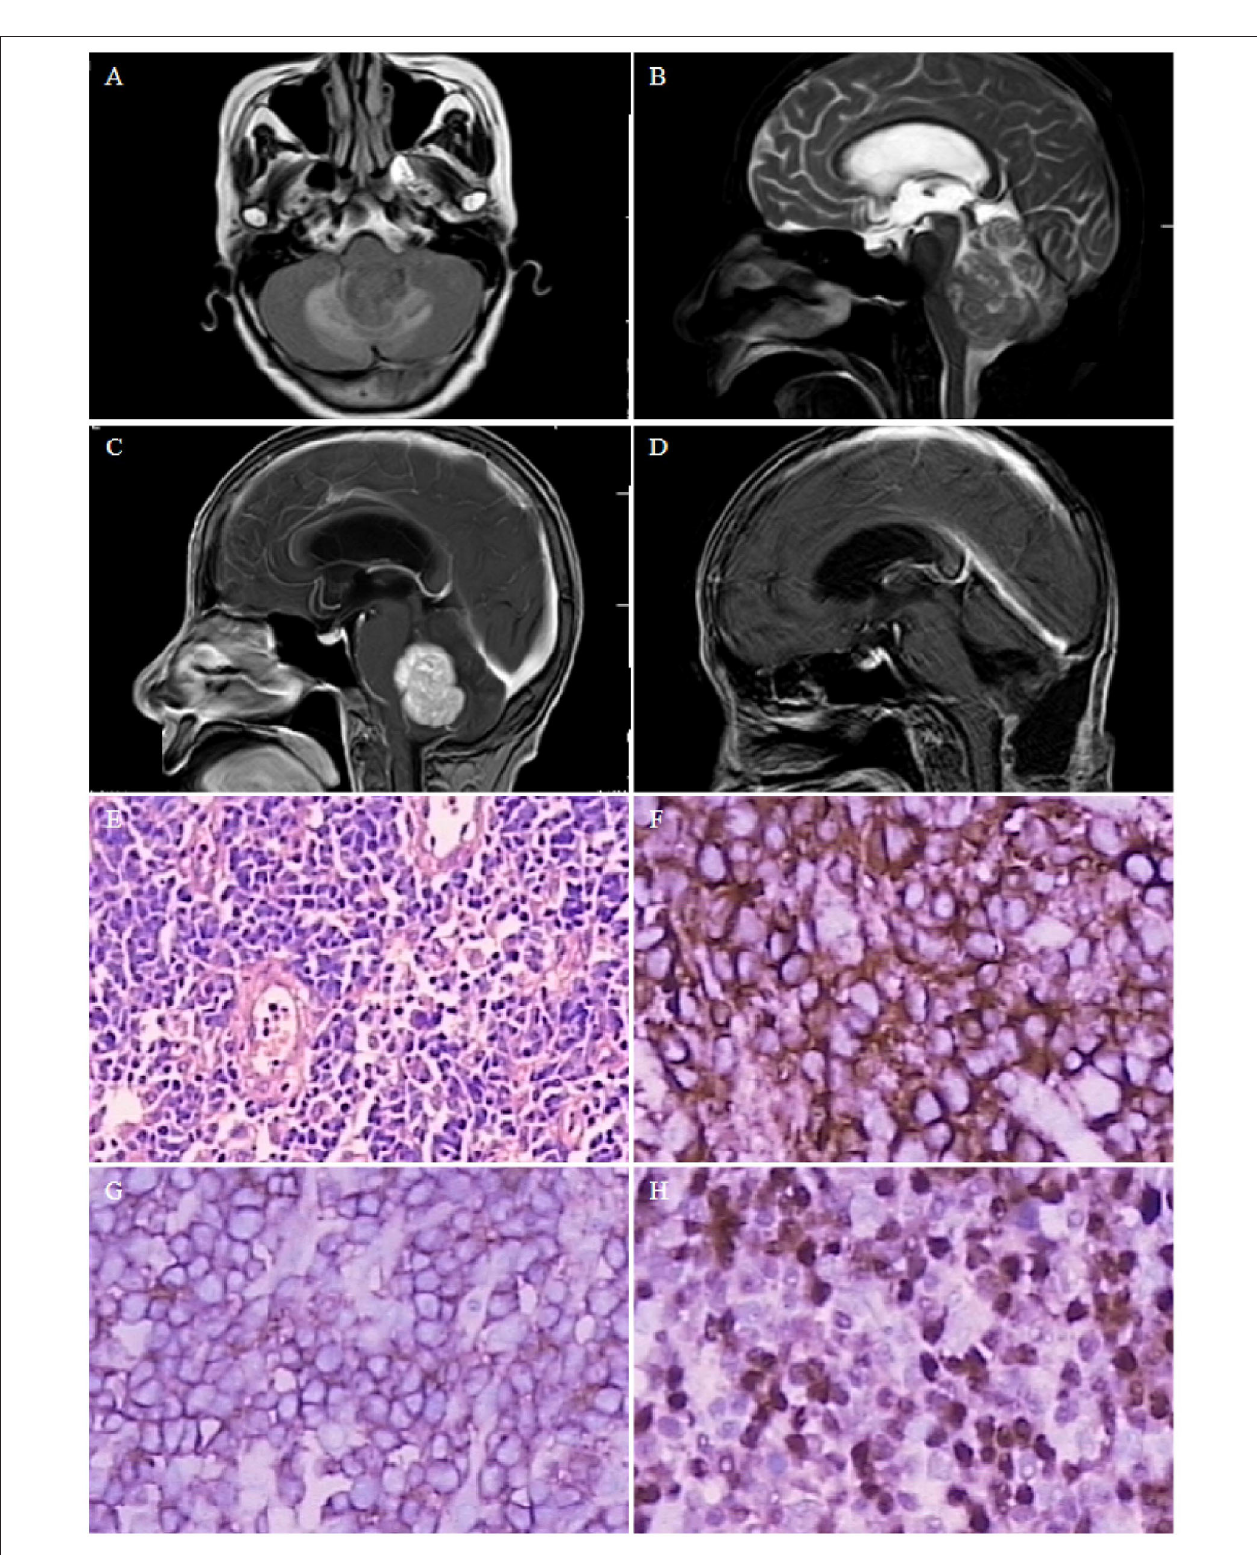
FIGURE 2 | Case 1. Magnetic resonance image of a 4.0 × 2.8-cm solid mass in the fourth ventricle, with supratentorial hydrocephalus. (A) T1-weighted image showing low signal. (B) T2-weighted image showing low signal. (C) Homogeneous enhancement on contrast-enhanced T1-weighted images. (D) Postoperative magnetic resonance image showing no residual lesion, and obstructive hydrocephalus is relieved. Pathological microscopic examination shows diffuse large B-cell infiltration [ (E) hematoxylin and eosin, 200 × magnification], including CD20- [ (F) , 400 × magnification], LCA- [ (G) , 400 × magnification], and MUM-positive [ (H) , 400 × magnification]